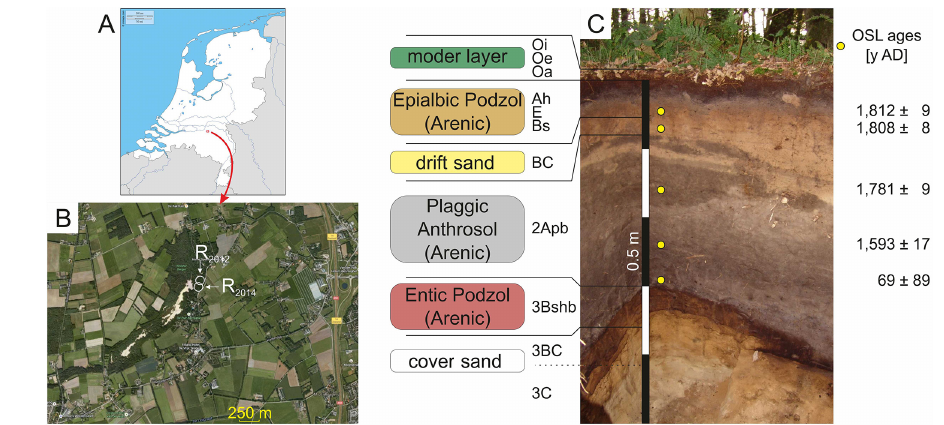
Figure 1. (a) Location of the study site in the Netherlands (source: www.d-maps.com). (b) The nature reserve Bedafse Bergen and its surroundings (source: http://maps.google.de, 17 July 2015). The profile of the current study, “R 2014 “, is located approximately 50m south of the profile “R 2012 “ described by Van Mourik et al. (2012). (c) The profile of the current study, R 2014 , containing several sequences of soil development, reflecting the development of landscape and land use from Late Glacial until today. Optically stimulated luminescence (OSL) ages of drift sand and Plaggic Anthrosol were adopted from the nearby profile R 2012 (Van Mourik et al.,